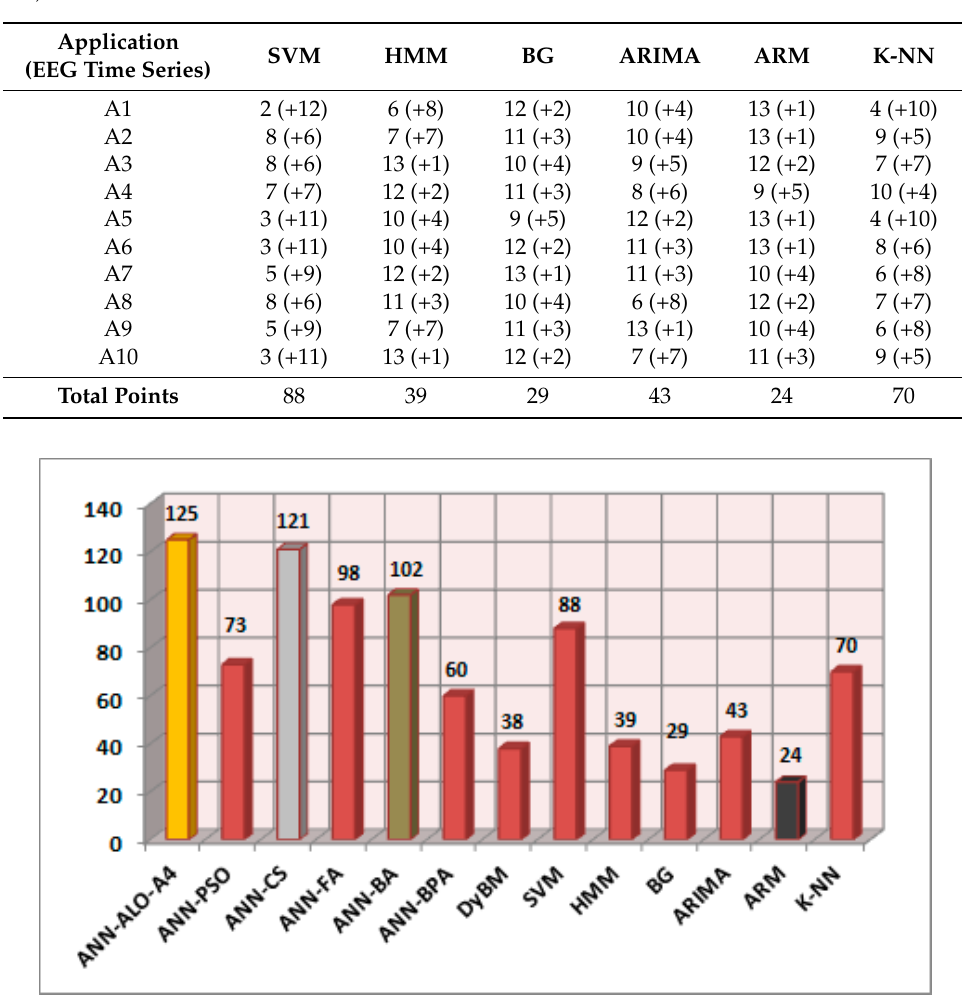
Figure 9. Ranking (with points) of the employed approaches used to predict the EEG time series in this study.